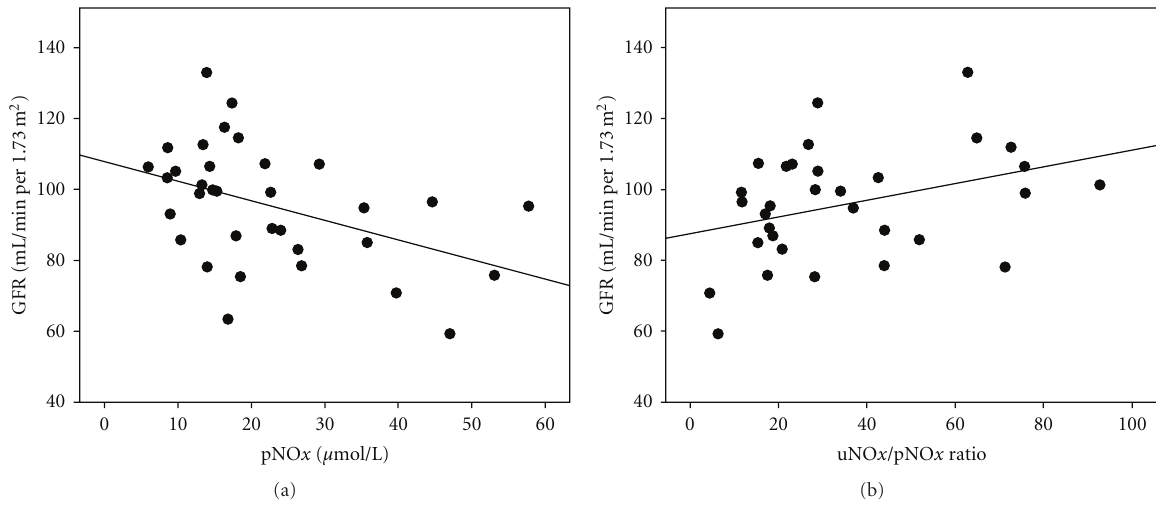
Figure 3: Relationship between GFR and pNO x (a) and the uNO x /pNO x ratio (b).